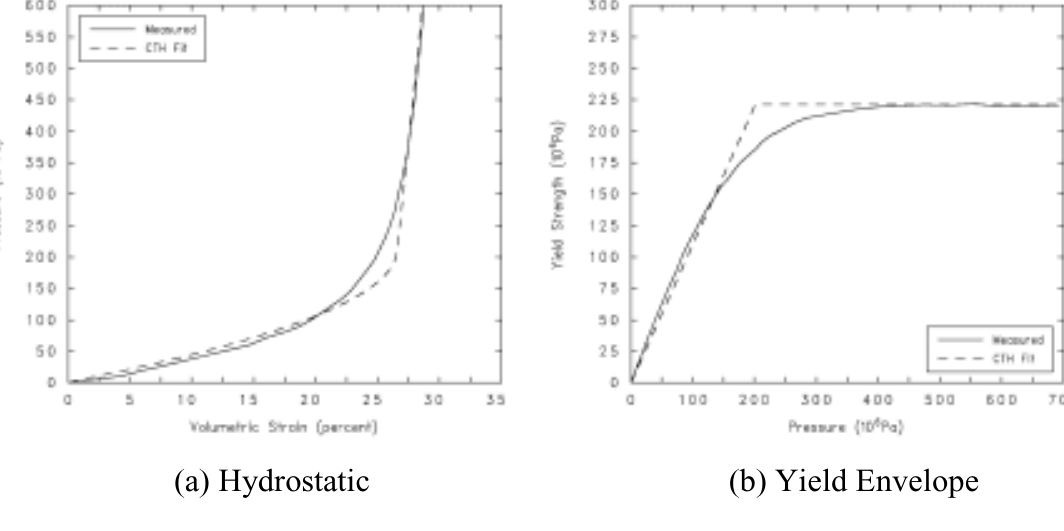
Fig. 9. Material response for